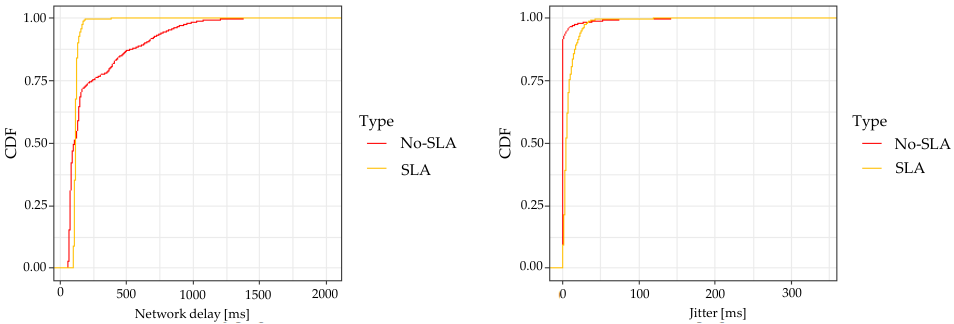
Figure 8. MNO network performance (latency and jitter) according to SLA agreement and a regular